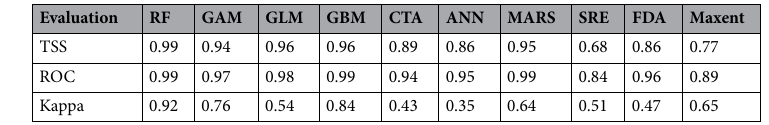
Table 1. Individual model performance by ROC, TSS and Kappa evaluation metrics.